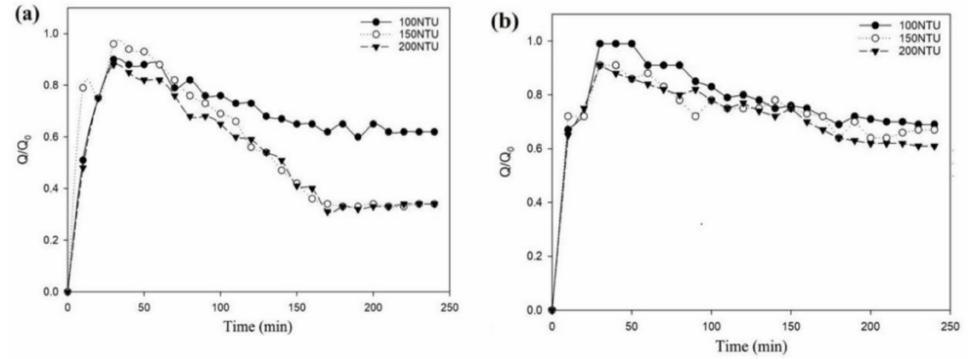
Figure 10. ( a ) Clogging rate of the medium without the rubber dam. ( b ) Clogging rate of the medium with the rubber